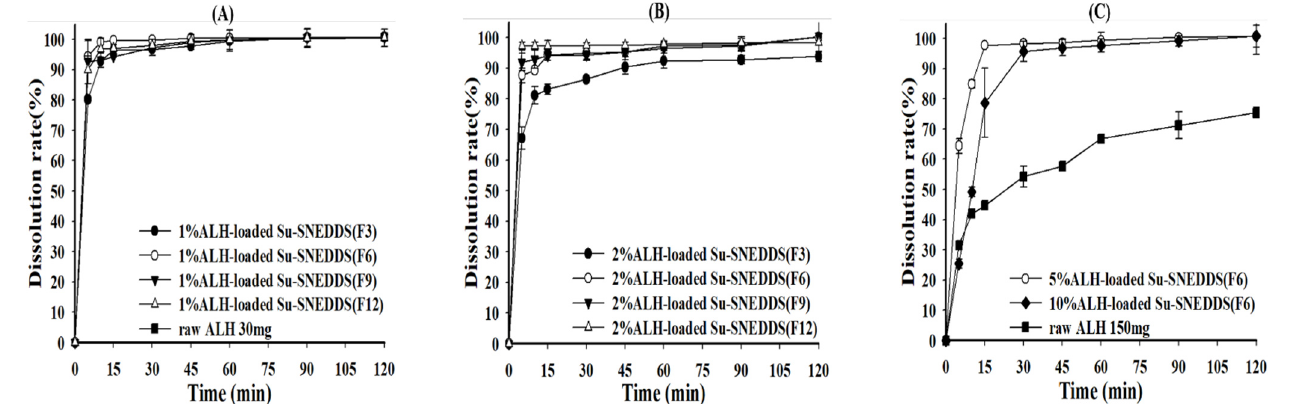
Figure 5. Dissolution profiles of raw ALH (( A ) 30 mg ALH; ( C ) 150 mg ALH) and ALH-loaded Su-SNEDDS (( A ) 1% ALH-loaded; ( B ) 2% ALH-loaded; ( C ) 5% or 10% ALH-loaded) prepared from F3, F6, F9, and F12 in 1% SLS pH 1.2 buffer. Vehicle composition F3, F6, F9, and F12 are from Table